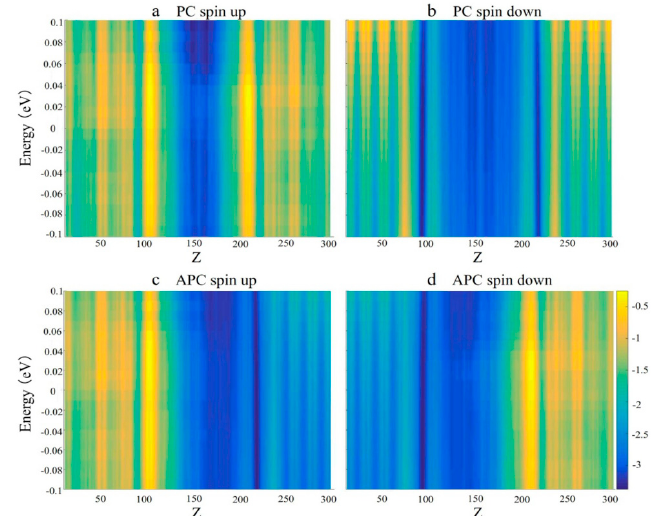
Figure 5. Local density of states (LDOS) for ( a ) PC spin-up; ( b ) PC spin-down; ( c ) APC spin-up; and ( d ) APC spin-down configurations for a PdF 3 based MTJ.